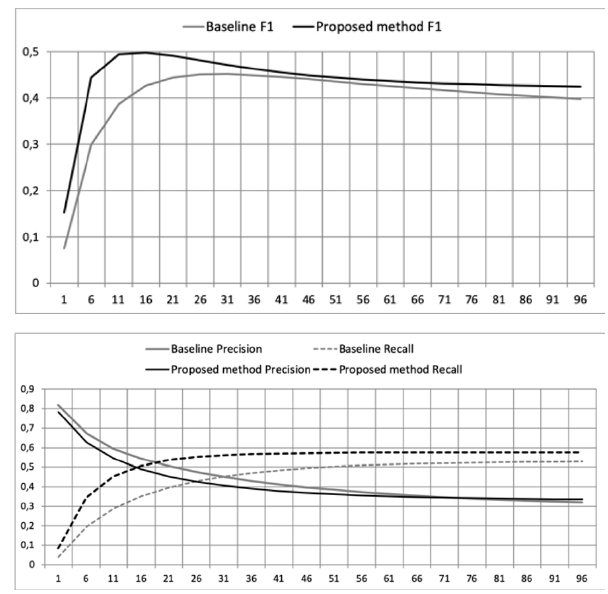
Figure 8. MovieLens recommendation accuracy. Top chart: F1 comparative between the NCF baseline and the proposed RNCF. Chart below: Precision and Recall comparative between the NCF baseline and the proposed RNCF; x-axis: number of recommendations (N).